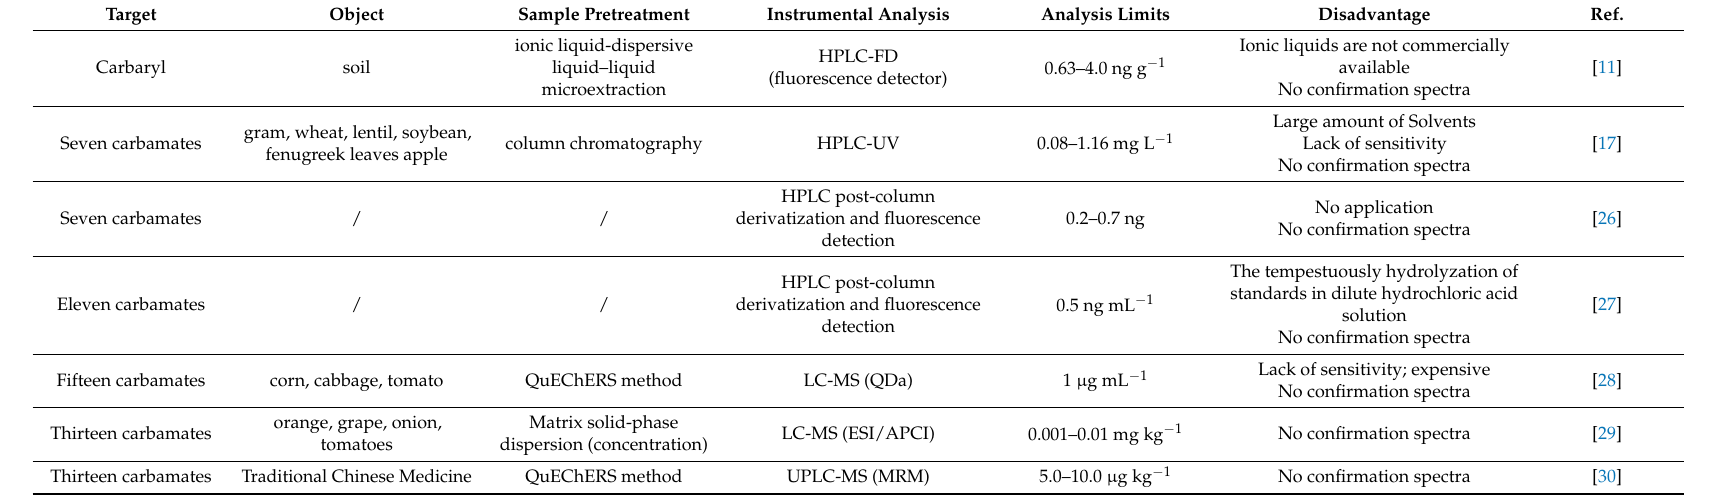
Table 1. Comparative study between the published analysis methods for